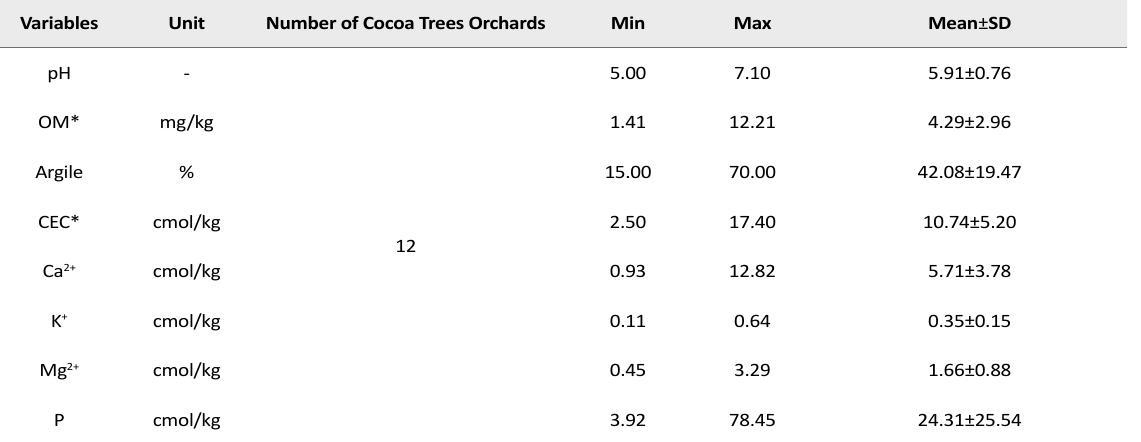
Table 4. Physico-chemical characteristics of the soils